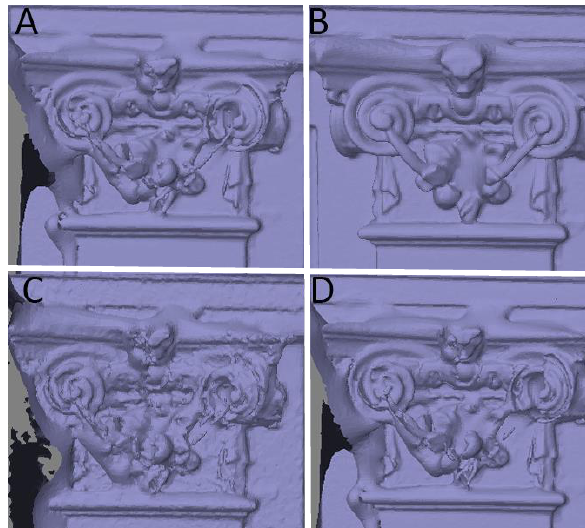
Figure 1. Meshes generated from clouds with differently computed normal vectors (particular methods are described in